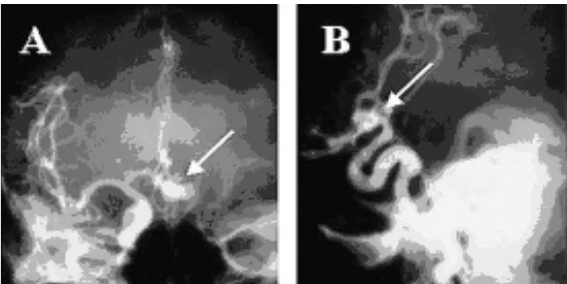
Fig. 2 - Caso 2: A - carotidoangiografia (ântero-posterior) e; B – carotidoangiografia (perfil). As setas indicam o aneurisma da artéria comunicante anterior .